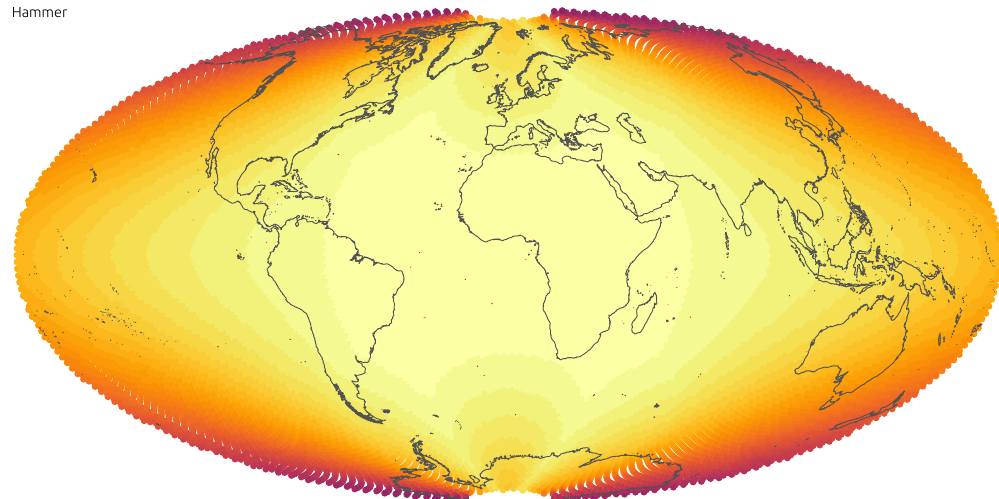
Figure 6. Mean absolute distance distortion at each indicatrix for the Sinusoidal, Mollweide and Hammer projections.